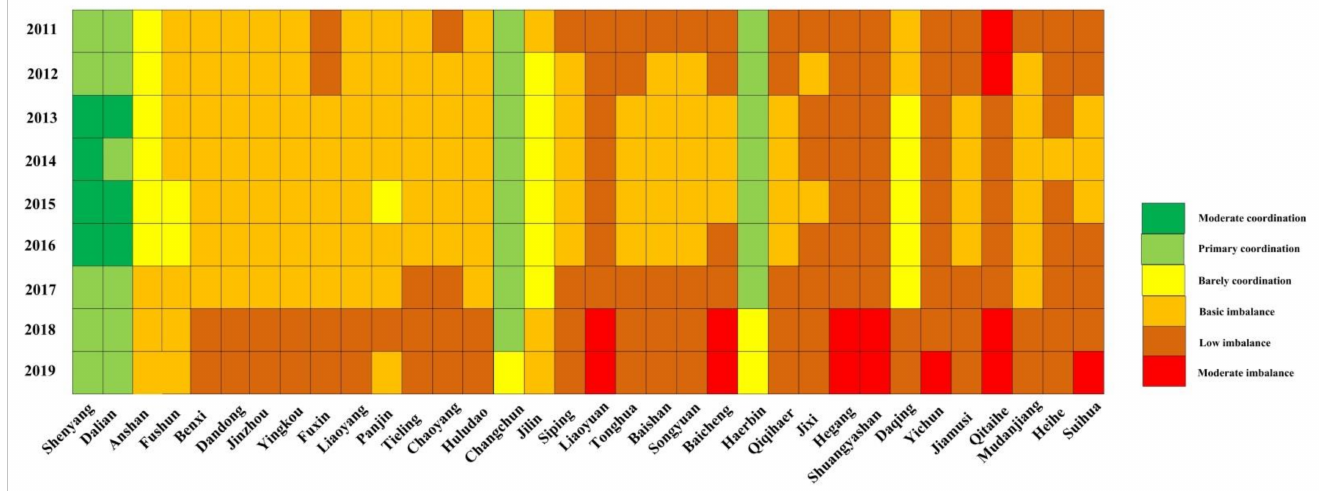
Figure 7. The proportion of each type of urban PHSs and RHSs coordination in northeast China in